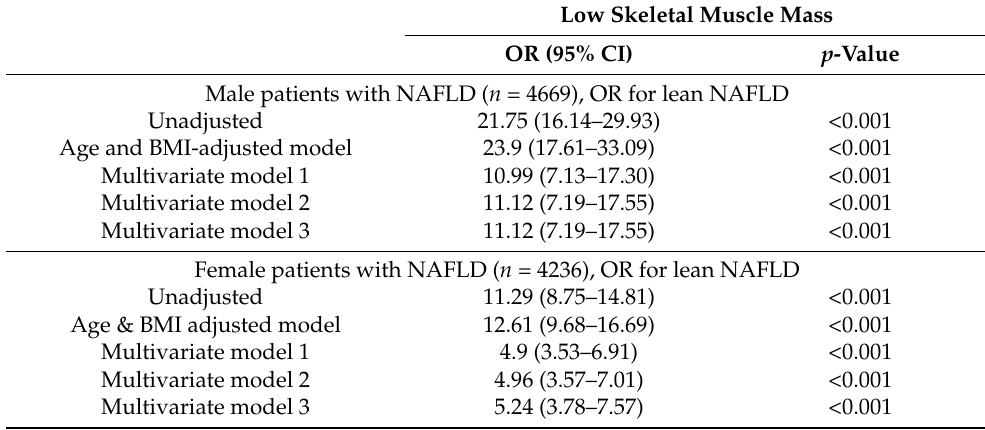
Table 4. Adjusted OR of low skeletal muscle mass for lean NAFLD patients according to sex differences.